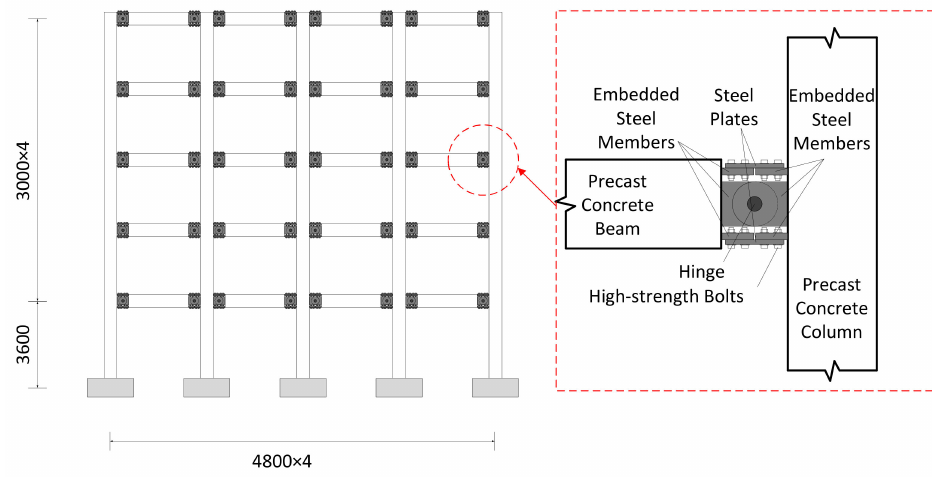
Figure 2. Position of the beam-column connection in the frame.